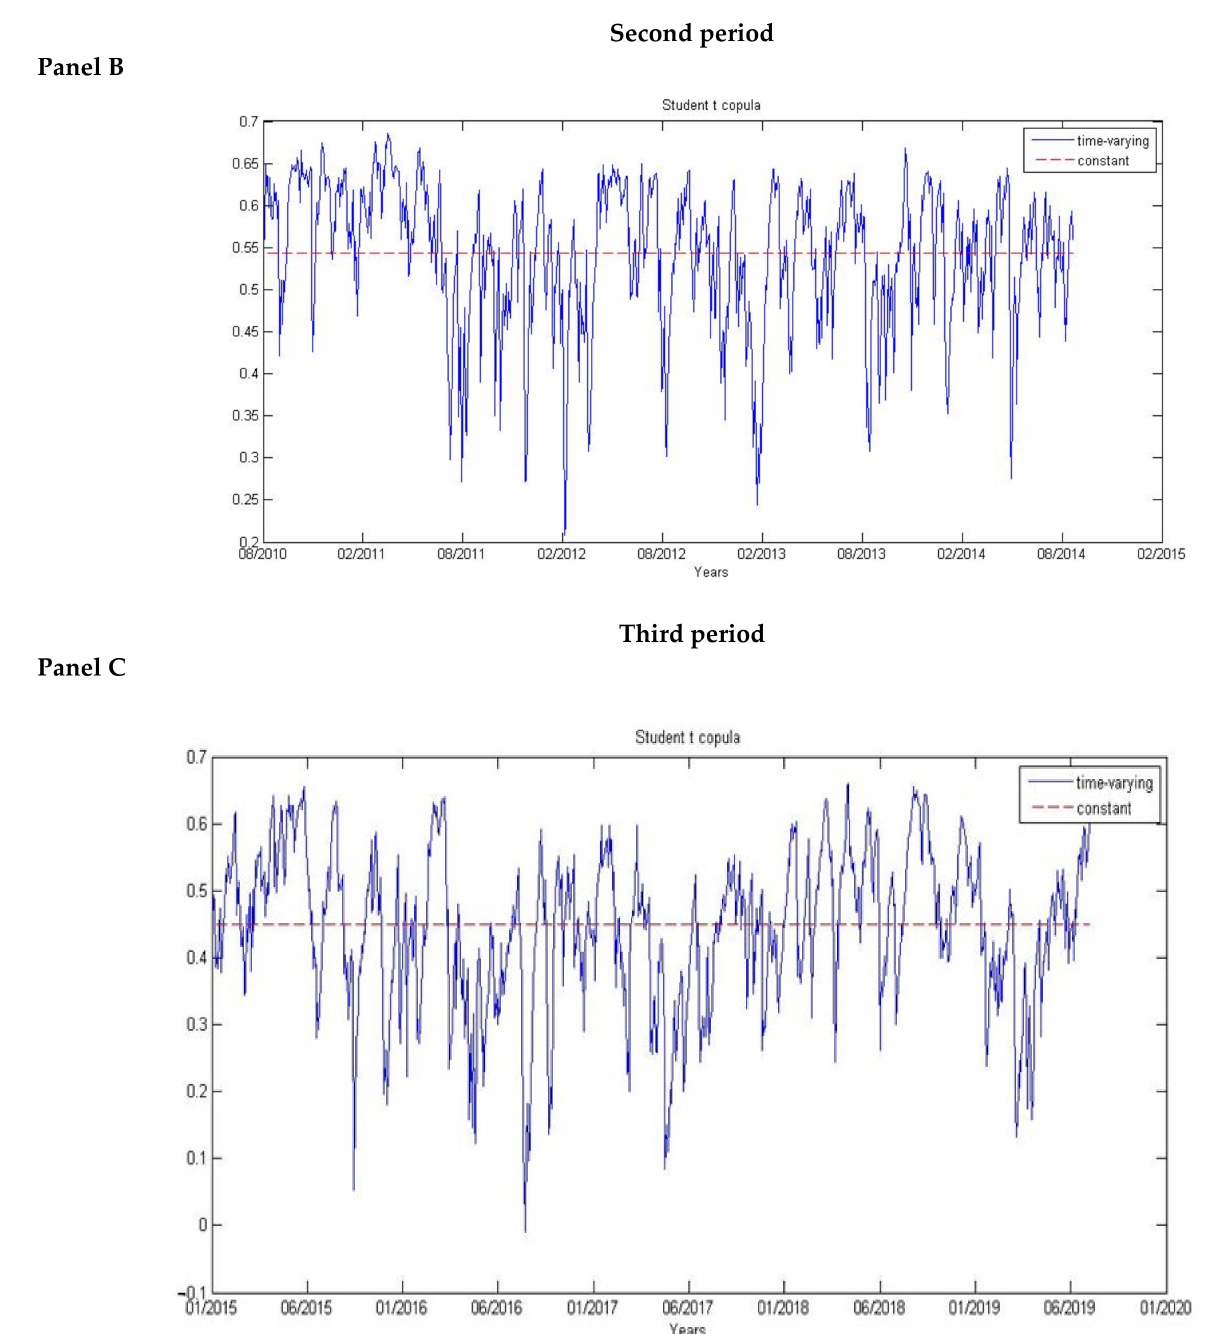
Figure 4. Time varying Student t copula for Minneapolis-MATIF price